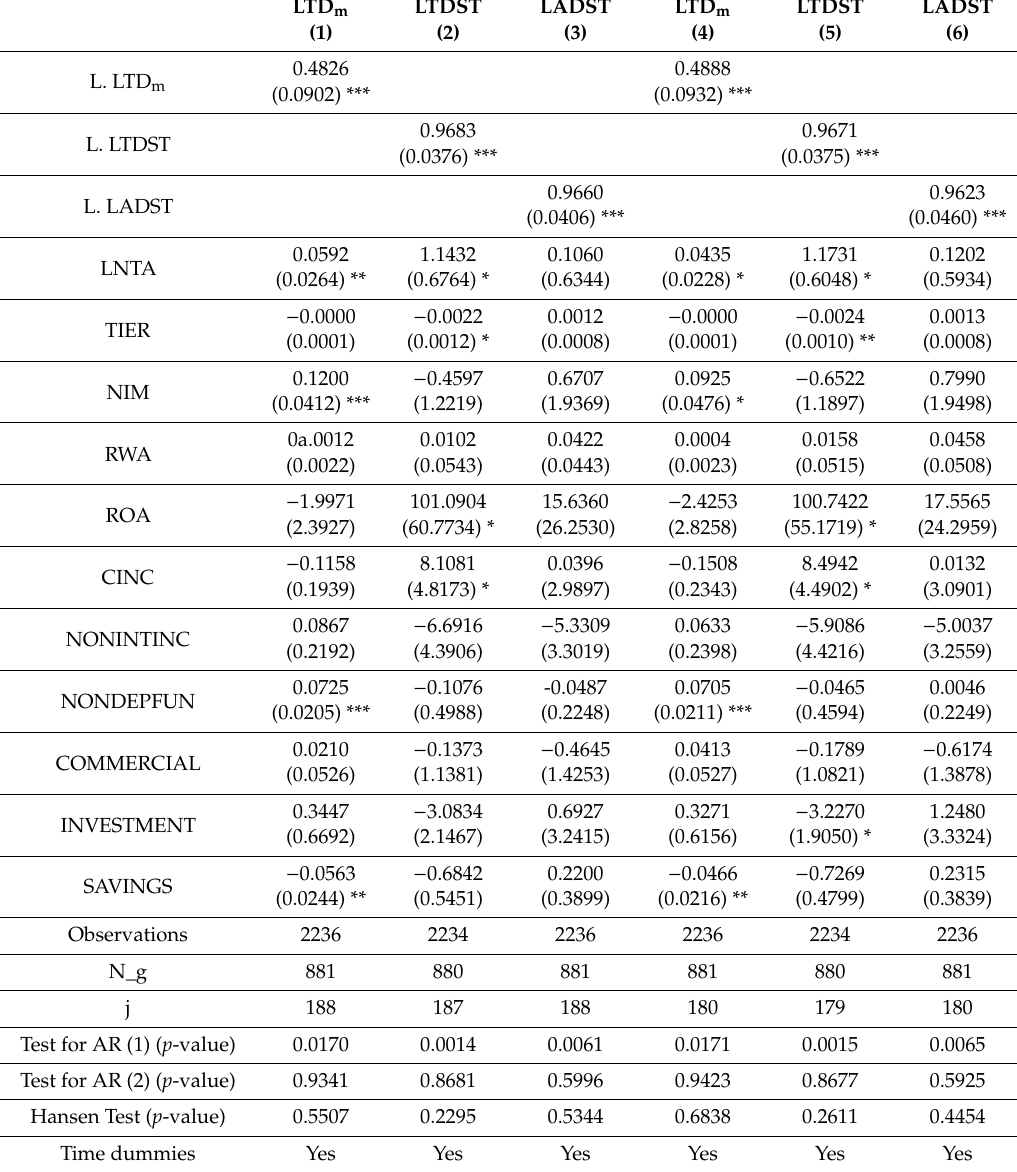
Table 5. Two-step system Generalized Method of Moments